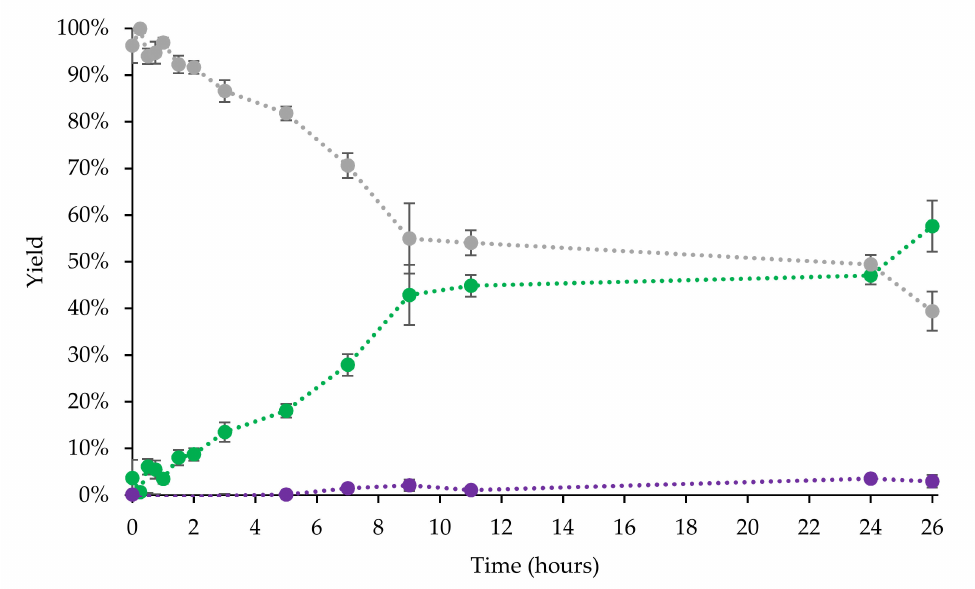
Figure 2. Bioreactor biotransformation conversion of 1 (grey dots) into 2 (green dots) and 3 (purple dots) as analyzed by HPLC. Percentage amounts in sample were determined using calibration curves obtained from commercially bought